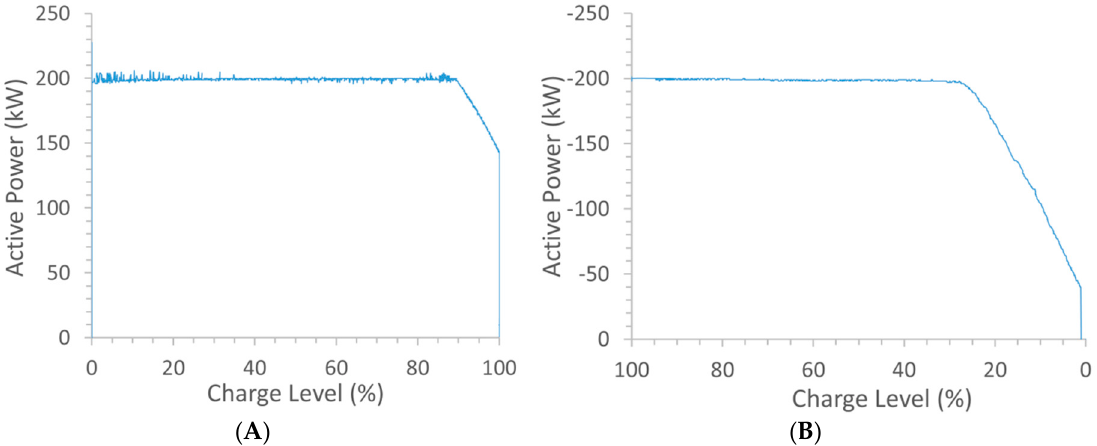
Figure 2. Power profiles on ( A ) charging and ( B ) discharging across the charge levels 0–100% at 200 kW power.